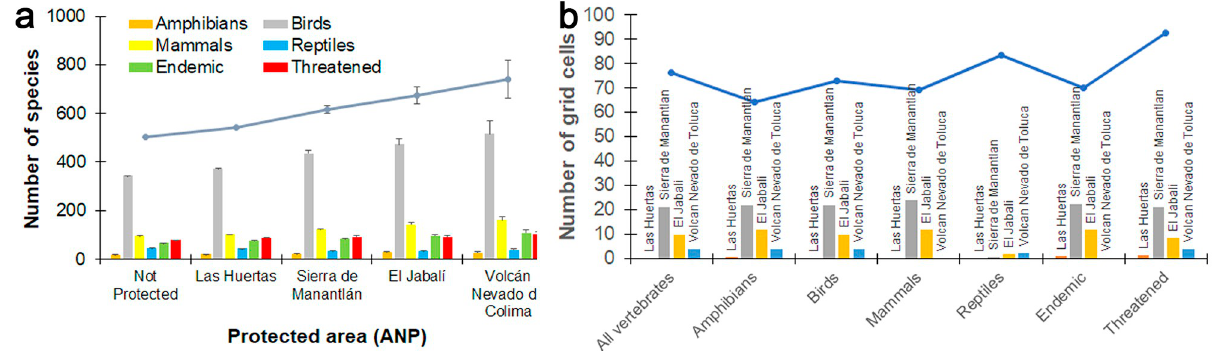
Fig 10. a) Mean number ( ± SE) of species included in protected and not protected grid-cells and b) number of significant (90, 95 and 99% confidence) hotspot grid-cells included in protected and unprotected areas in Colima, Mexico. Color code (a) all vertebrates: Blue line; amphibians: Orange bar; birds: Gray bar; mammals: Yellow bar; reptiles: Blue bar; endemic species: Green bar; and threatened species: Red bar. The blue line in (b) indicates total number of grid cells in each group located in areas with no official protection